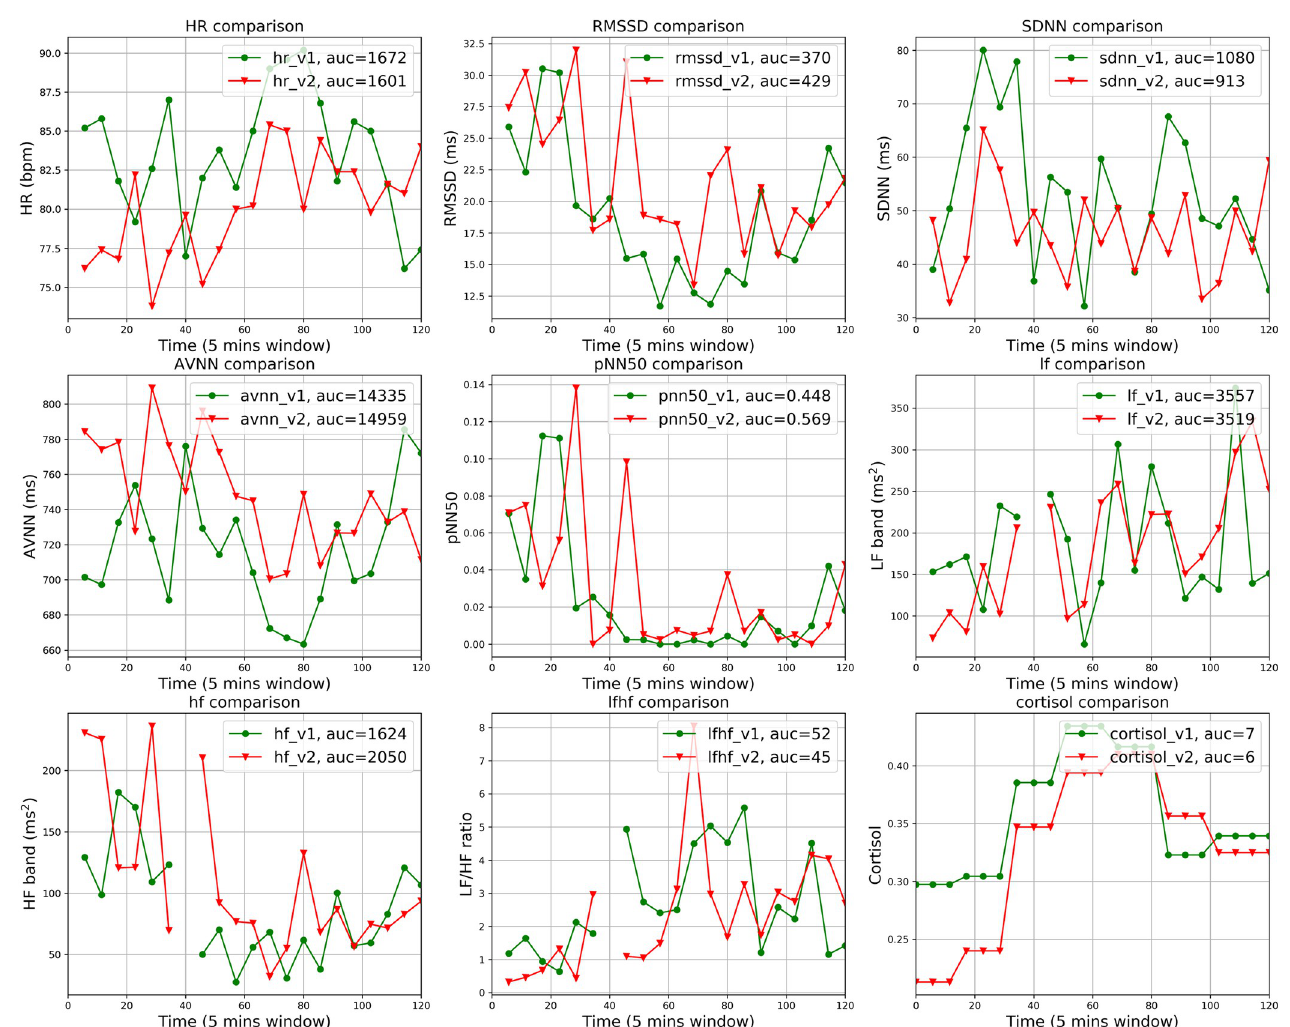
Fig 4. Comparison of the HR, HRV parameters, and cortisol between visit 1 and visit 2 in 5-minute segments for a sample participant. This participant did not demonstrate any clear difference among all the features, including salivary